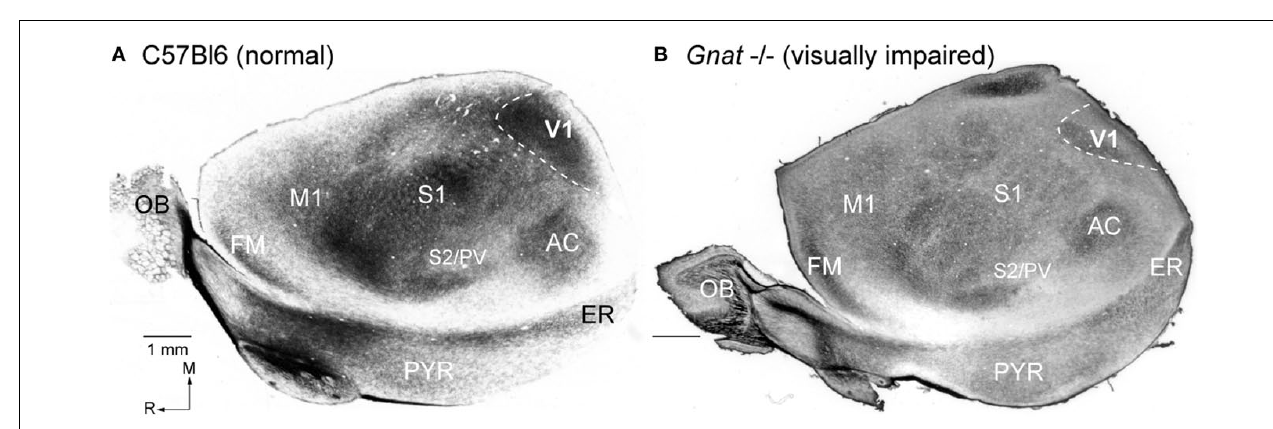
modality mapped to that location (B,D) . Unlike normal animals, in which neurons in V1 respond solely to visual stimulation, in Gnat − / − mice neurons at only a few recording sites responded only to visual stimulation. At most other sites in which neurons were responsive, they responded to auditory stimulation, somatosensory stimulation or some combination of modalities of stimulation. Medial is to the top and rostral is to the left in all images. X = No Response. Scale bars = 1 mm.